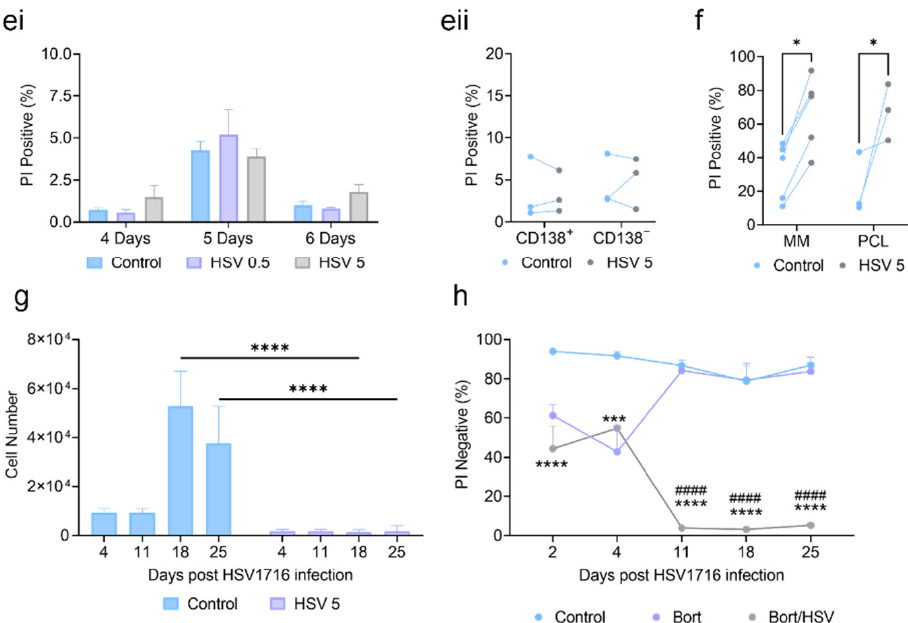
Figure 1. HSV1716 induces potent cell death in myeloma cells. ( a ) JJN-3 and U266 cells were infected with HSV1716-GFP at an MOI of 0.5 or 5. After 24, 48, and 72 h of infection, GFP expression was assessed using flow cytometry on viable cells. ( ai ) Representative flow cytometry GFP histogram plots of JJN-3 or U266 cells at 24 or 48 h after infection with the control, HSV1716 MOI 0.5, or HSV1716 MOI 5. GFP expression was plotted in ( aii ) JJN-3 and ( aiii ) U266 cells. Data are means ± SEMs, n = 3, **** = p < 0.0001 with respect to the control, analyzed using a two-way ANOVA. ( b ) JJN-3 or U266 cells were infected with HSV1716 at increasing MOIs (5–100). ( bi ) The cell count analysis shows significant reductions in cell numbers 4 days post-infection. Data are means ± SEMs, n = 3, **= p < 0.01, **** = p < 0.0001 with respect to the control, analyzed using a two-way ANOVA. ( bii ) Analyses at 24, 48, and 72 h showed a rapid response to HSV1716 in both myeloma cell lines. Data are means ± SEMs, n = 3, *** = p < 0.001, **** = p < 0.0001 with respect to the control, analyzed using a one-way ANOVA. ( c ) Four myeloma cell lines were infected with HSV1716 for 4 days and the viability was assessed using a flow cytometry analysis of PI-stained cells. All myeloma cell lines showed a significant increase in PI positivity. Data are means ± SEMs, n = 3, **** = p < 0.0001 with respect to the control, analyzed using a one-way ANOVA. ( d ) JJN-3 cells were infected with HSV1716 at an MOI of 5. At 8, 16, and 24 h post-infection, the total RNA was extracted and an RT-qPCR assay was performed to detect viral transactivator and replication genes ICP0 ( di ) and ICP8 ( dii ), both of which were significantly upregulated at both 8 and 24 h. ( ei ) Primary human lymphocytes from healthy donors were infected with HSV1716 at MOIs of 0.5 and 5. Cell viability was assessed 4, 5, and 6 days post-infection using a flow cytometry analysis and showed no significant increase in PI staining at any time point. Data are means ± SEMs, n = 3, analyzed using a one-way ANOVA. ( eii ) CD138 + and CD138 − cells isolated from BM aspirates from healthy donors were treated with HSV1716 at MOI 5 and the cell viability was assessed 4 days post-infection using a flow cytometry analysis and PI staining. Data are means, n = 3, analyzed using a Student’s T-test. ( f ) CD138 + cells isolated from BM aspirates from myeloma (MM) or plasma cell leukemia patients (PCL) who were treated with HSV1716 at an MOI of 5. Cell viability was assessed 4 days post-infection using a flow cytometry analysis and PI staining. HSV1716 induced a significant increase in cell death in primary CD138 + MM and PCL cells compared to untreated controls. Data are means, n = 6 for MM, n = 3 for PCL, * = p < 0.05 with respect to the control, analyzed using an ANOVA with Sidak’s multiple comparison. ( g ) Infection of myeloma cells lines with HSV1716 results in a long-term reduction in the myeloma cell number. Infected, but not control, JJN-3 cells showed consistent decreases in